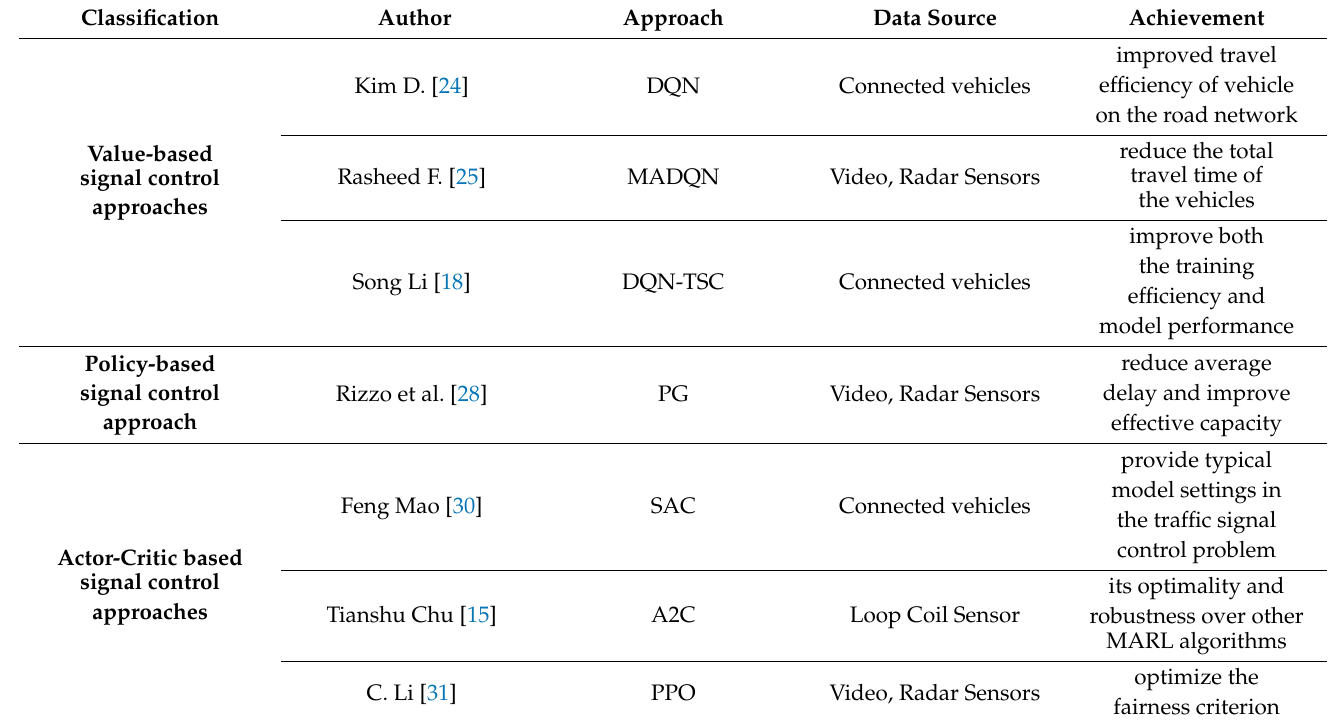
Table 3. Classification and comparison of DRL signal control